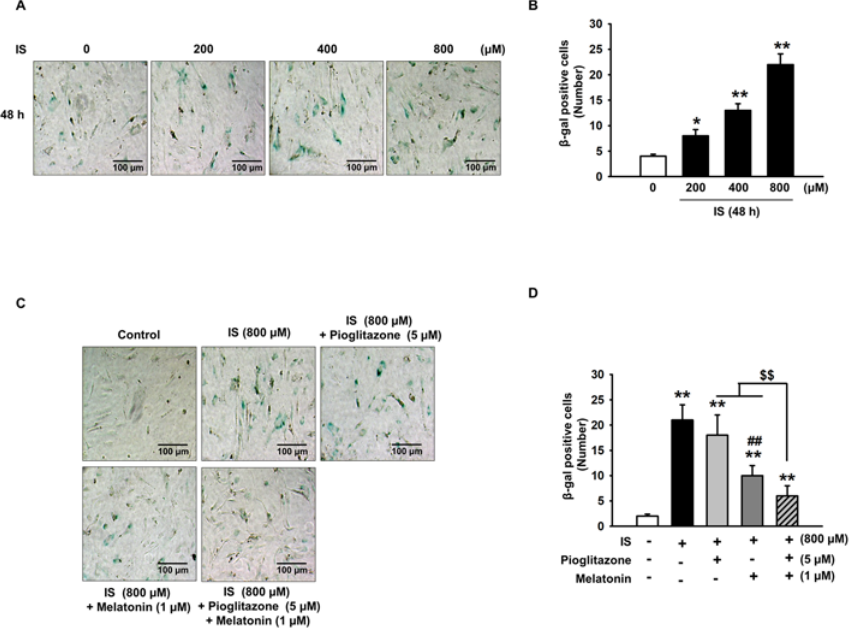
Figure 1. Inhibition of indoxyl sulfate ‐ induced cell senescence by melatonin and pioglitazone. ( A ) Mesenchymal stem cells (MSCs) were exposed to indoxyl sulfate (IS), and representative images of senescence ‐ associated beta ‐ galactosidase (SA ‐β‐ gal) activity stain are shown. Scale bar = 100 μ m; ( B ) Number of SA ‐β‐ gal positive cells ( n = 3). The values represent the mean ± standard error of the mean (SEM). * p < 0.05 and ** p < 0.01 vs. control (Analysis of variance (ANOVA), using Dunnett’s post ‐ hoc test); ( C ) SA ‐β‐ gal activity stain assay representative image of IS ‐ exposed MSCs treated with pioglitazone and melatonin. Scale bar = 100 μ m; ( D ) number of SA ‐β‐ gal positive cells ( n = 3). The values represent the mean ± SEM. ** p < 0.01 vs. control, ## p < 0.01 vs. IS only, $$ p < 0.01 vs. pretreatment with pioglitazone or melatonin and IS (ANOVA, using Tukey’s post ‐ hoc test).